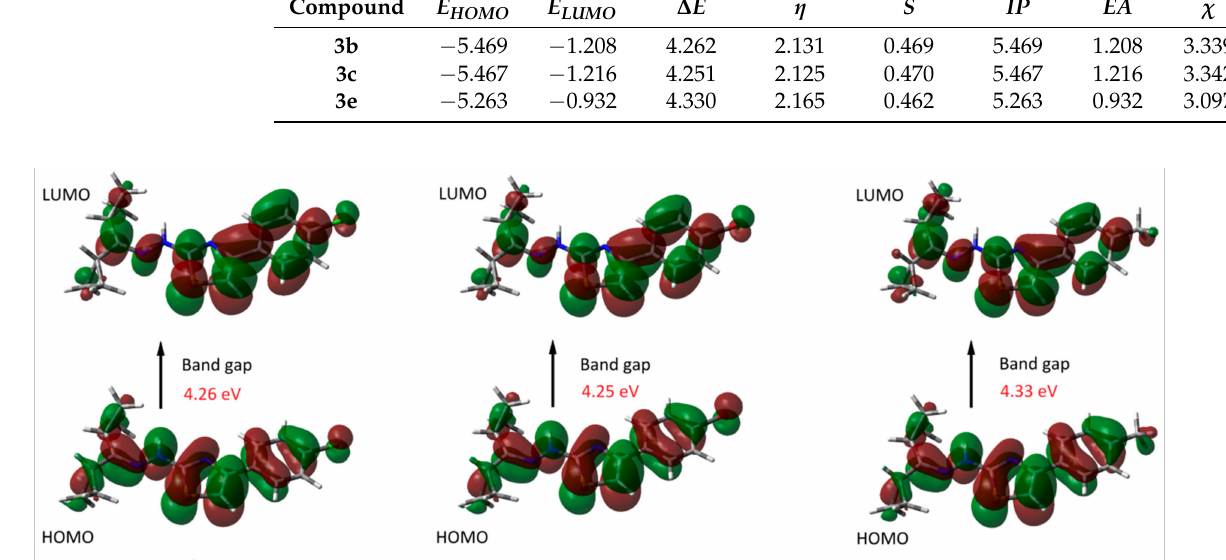
Figure 1. Molecular orbital distribution plots of HOMO-LUMO (Highest Occupied Molecular Orbital-Lowest Unoccupied Molecular Orbital) for compounds 3b , 3c and 3e obtained at the B3LYP/6-311G** level of approximation.